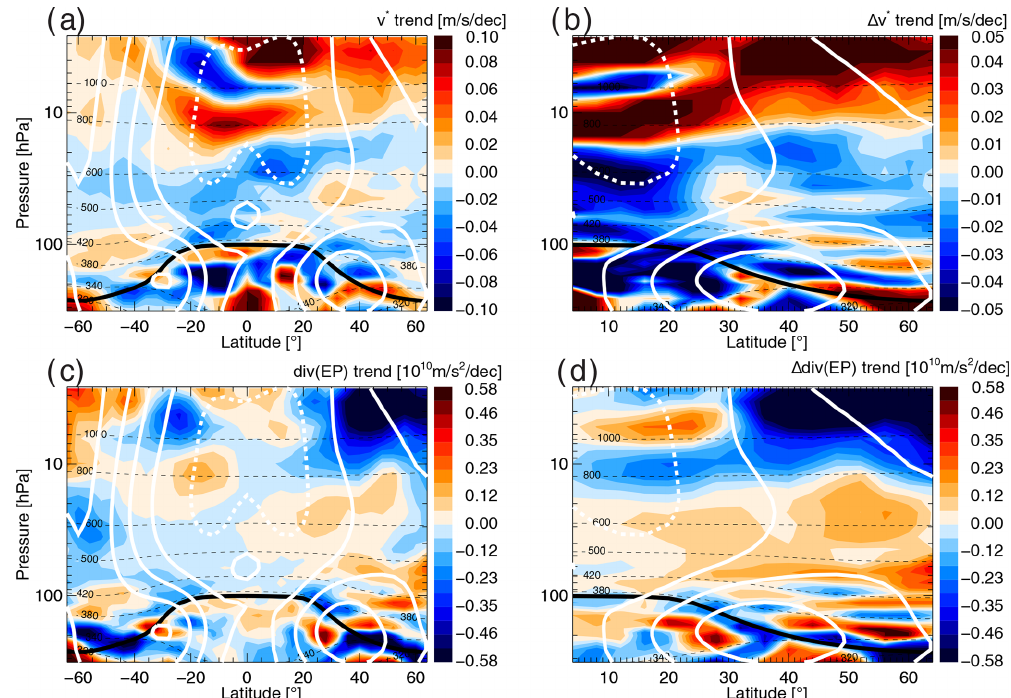
Figure 4. (a) Trend of meridional residual-circulation velocity v ∗ for the period 2005–2017 from ERA5 reanalysis. (b) Hemispheric dif- ference in v ∗ trend (NH minus SH). (c, d) Same but for Eliassen–Palm flux divergence. White lines show zonal wind contours (solid for positive, dashed for negative values), thin dashed black lines potential temperature levels and the thick black line the WMO